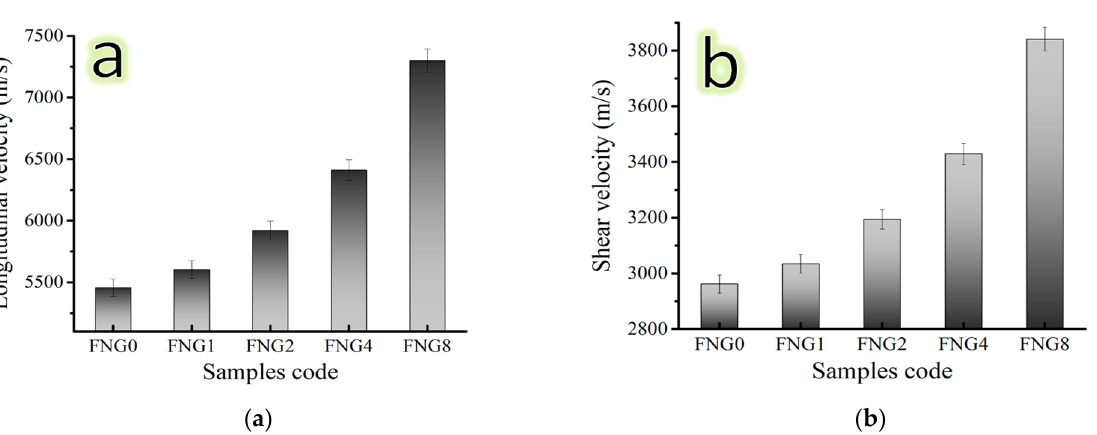
Figure 11. ( a ) Longitudinal and ( b ) shear velocity of sintered Fe–Cu alloy and its nanocomposites.